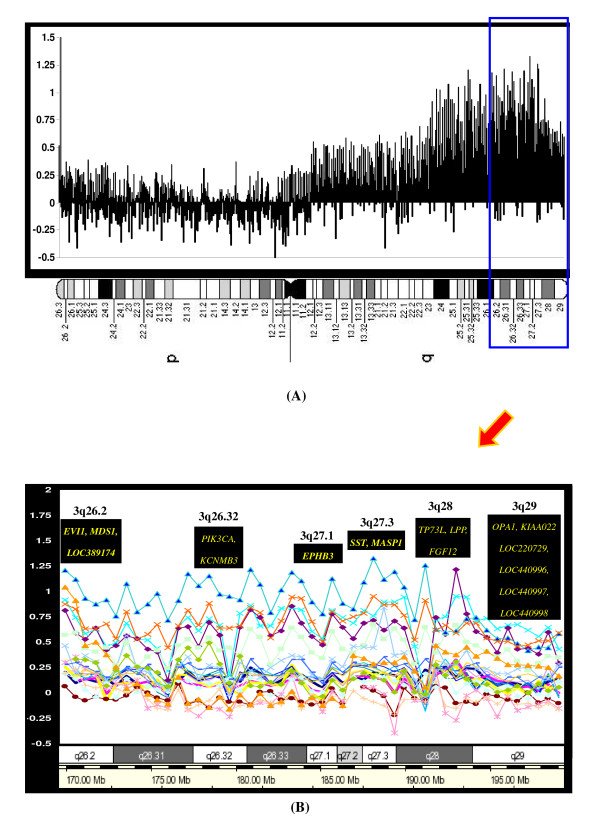
(A) Weighted frequency (%) diagram for chromosome 3 with high-level amplifications. In the intensity ratio profiles, the x-axis represents the map position of the corresponding clone and the intensity ratios were assigned to the y-axis. (B) More detailed profile on 3q26.2–q29 with the significantly associated genes in the SCC. The schematic presentation of cytogenetic bands as well as a map position is shown below the plot.